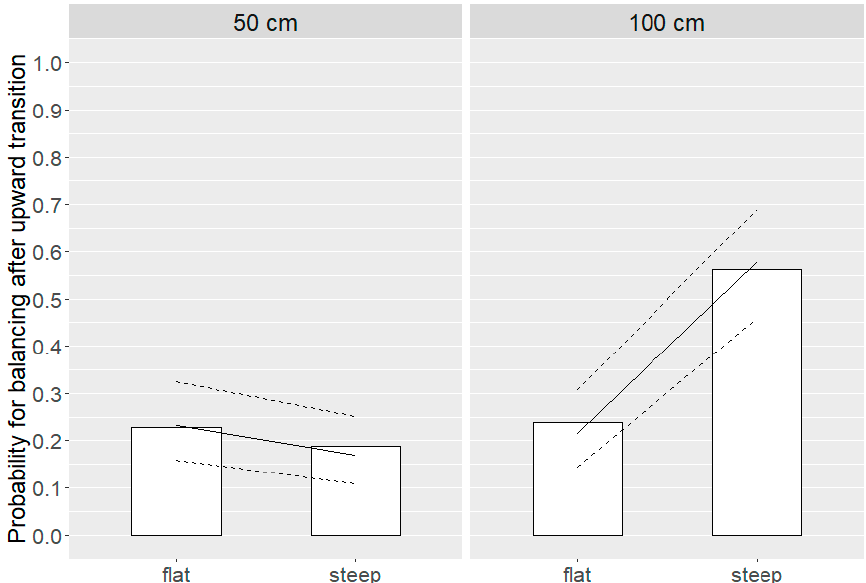
Figure 6. Probability for balancing movements after upward transitions of 50 cm and 100 cm distance and flat and steep angles (distance * angle: p = 0.0001). Bars represent the ratio of hens performing balancing movements after transitions of a specific condition. In addition, model estimates with estimated means (solid line) and 95 % confidence intervals (dashed lines) are shown.